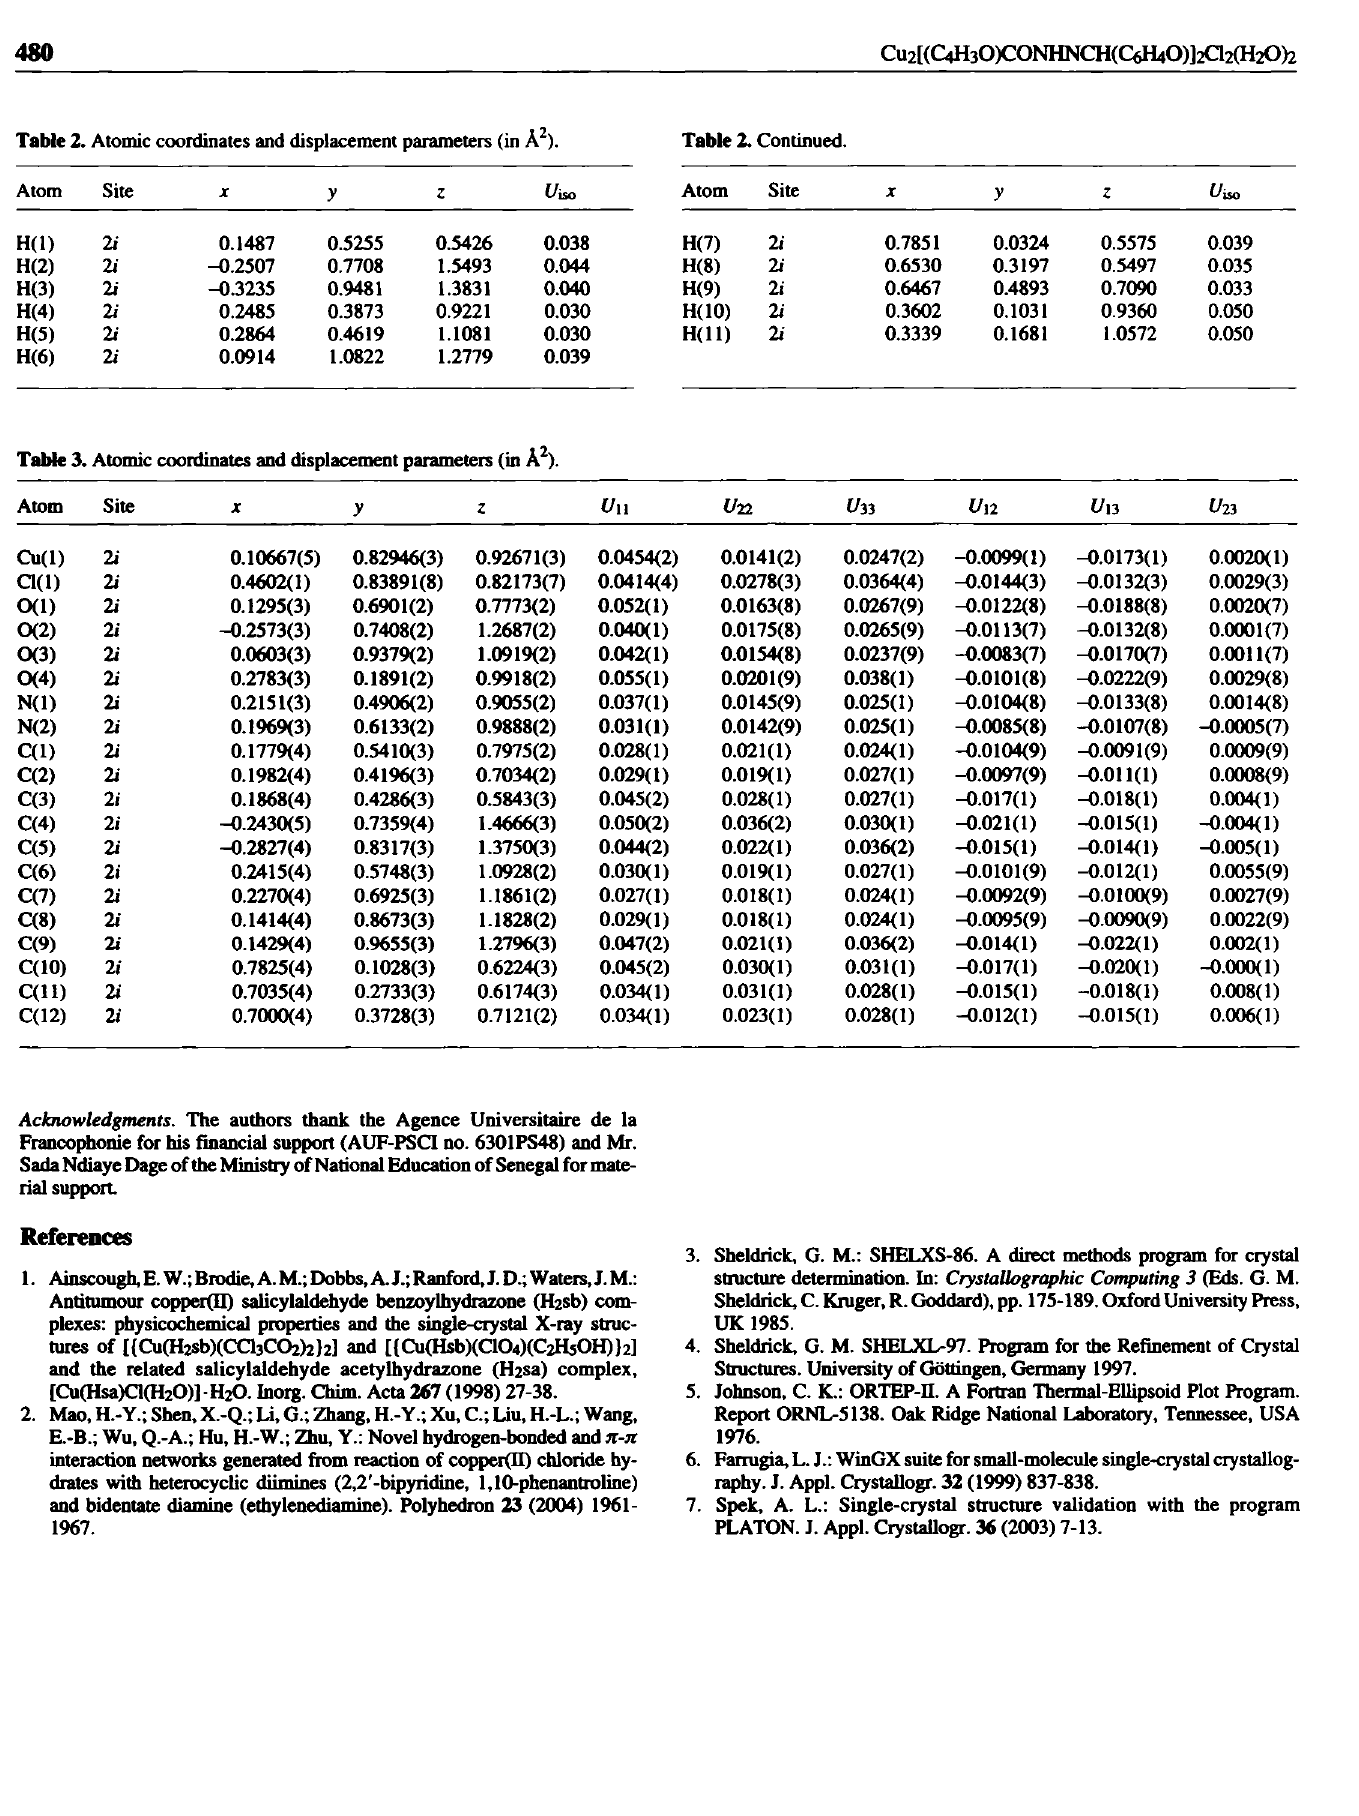
Table 2. Atomic coordinates and displacement parameters (in A 2 ). Table 2. Continued.